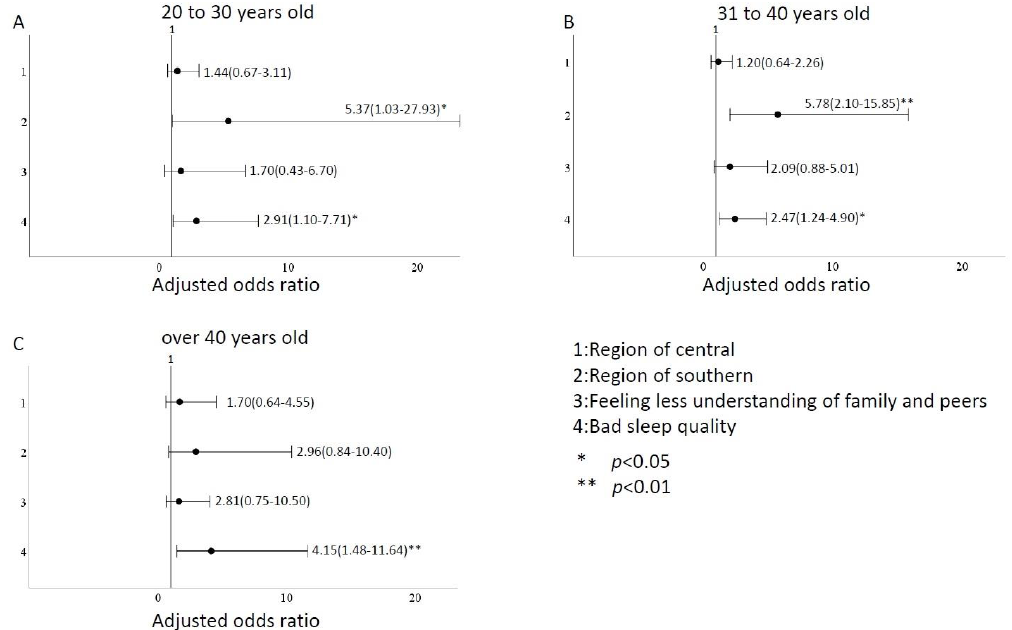
Figure 3. Comparison of odds ratio factors for anxiety levels in different ages. ( A ) between 20 – 30 years old ( B ) between 31 – 40 years old ( C ) over 40 years old.